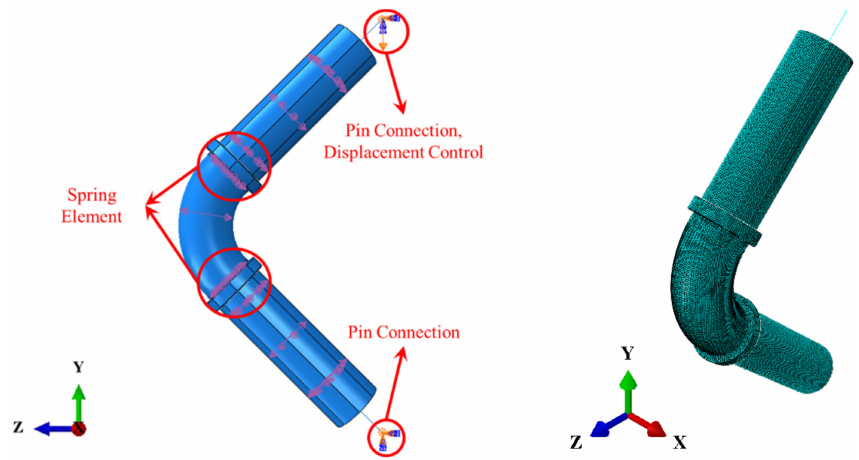
Figure 4. The FE model of press-to-connect elbow system.